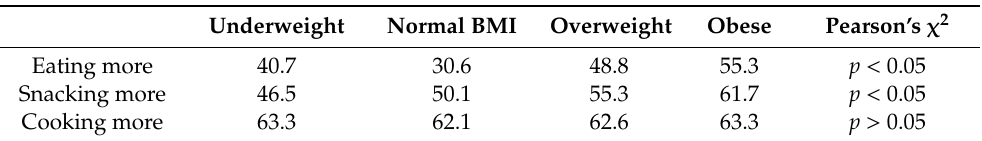
Table 2. The frequency (%) of increased food consumption, snacking, and cooking in the surveyed group ( n = 1097) across the BMI